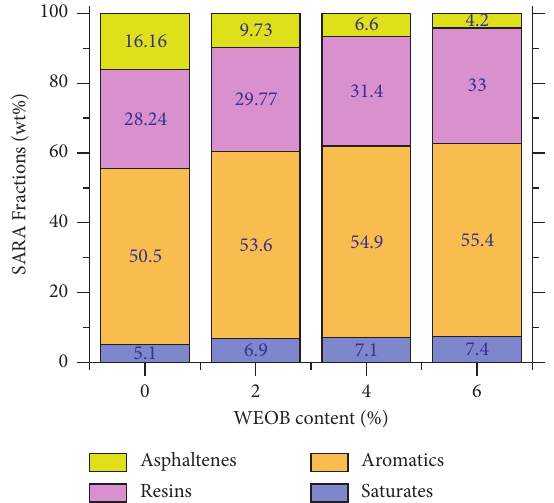
Figure 11: SARA fraction contents of WEOB/SBS-modified binders.